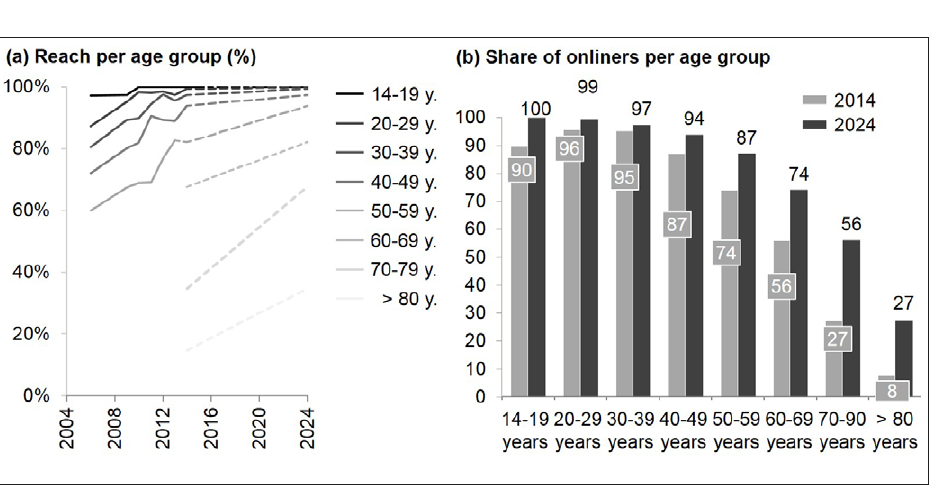
Figure 9: Modelling online usage on the basis of past developments. Source : Own elaboration based on model assumptions and measurements of online reach by AWA